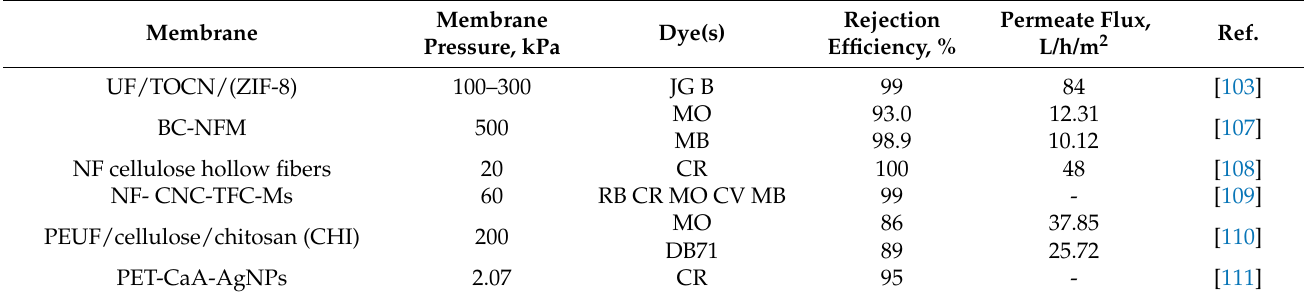
Table 8. Dye rejection efficiencies of the biopolymer-based membrane filtration technologies.